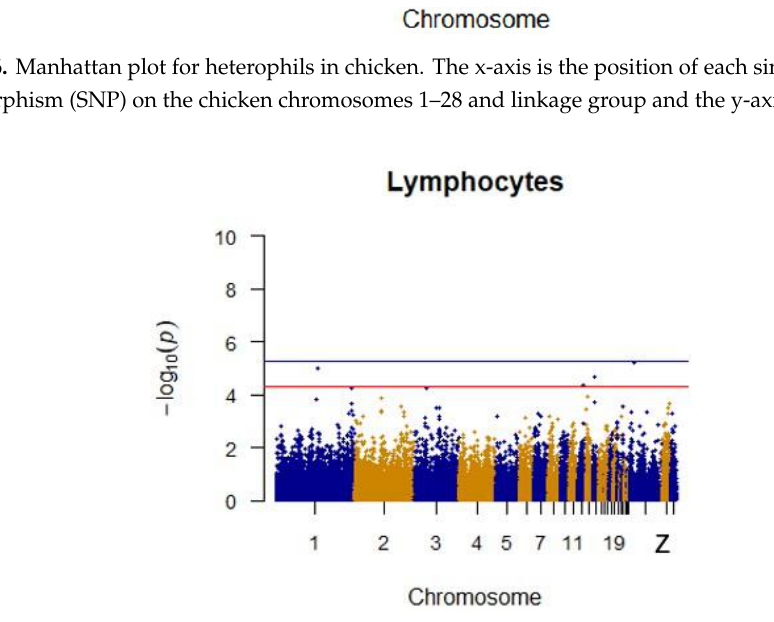
Figure 7. Manhattan plot for lymphocytes in chicken. The x-axis is the position of each single p nucleotide polymorphism (SNP) on the chicken chromosomes 1 – 28 and linkage group and the y-axis is the − log10 p -value.